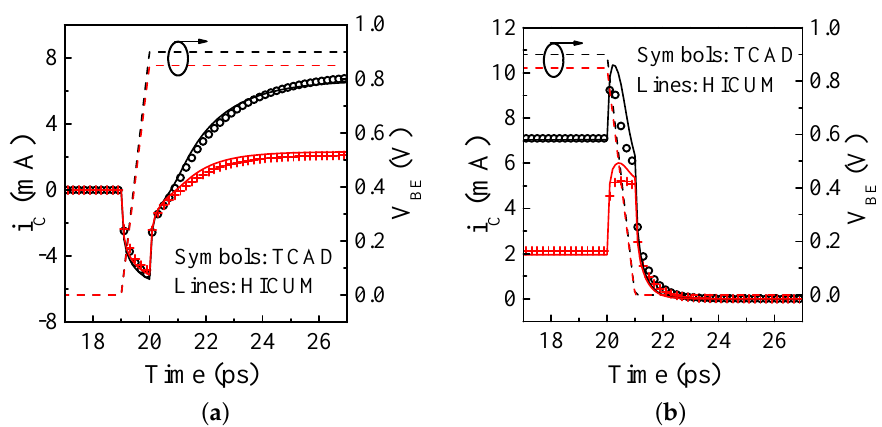
Figure 10. ( a ) Turn-on and ( b ) turn-off characteristics for the collector current i C ( t ) : comparison between TCAD (symbols) and HICUM (solid line with alit = 1) for a 0.09 µ m × 4.8 µ m SiGe HBT biased at constant V CE = 0.9 V (circles) and 0.85 V (plus). V BEs ( t ) have been shown as a dashed line to the right Y -axis.